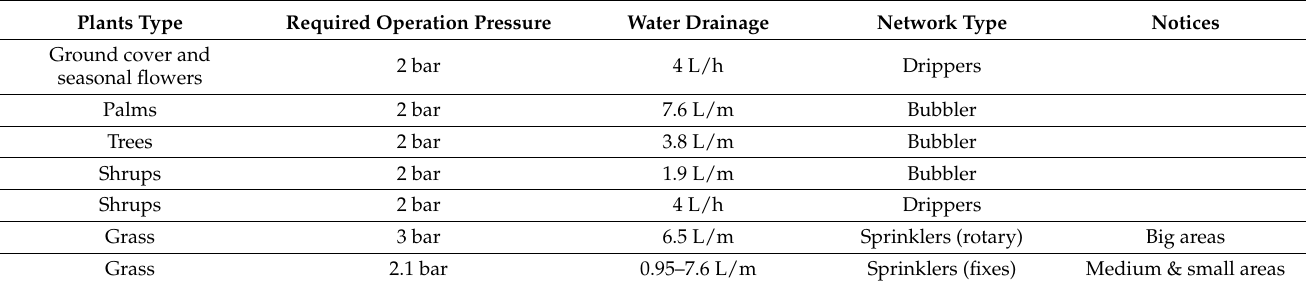
Table 2. Different irrigation network systems and water drainage rates.